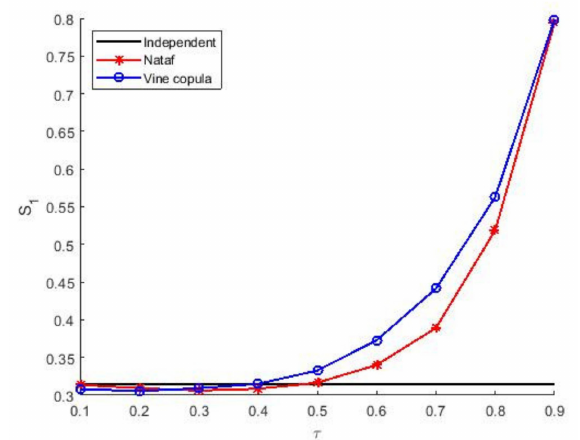
Figure 8. Values of S 1 obtained by two methods versus τ .